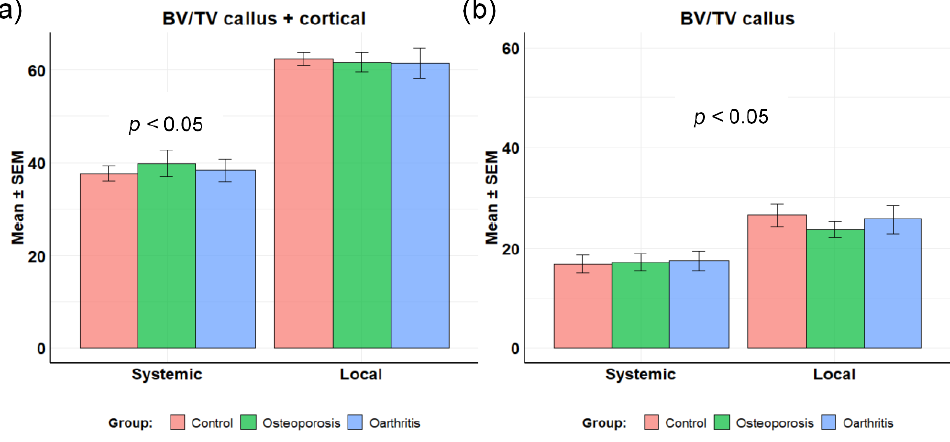
Figure 2. BV/TV of the callus region. ( a ) Callus+cortical BV/TV; ( b ) callus only BV/TV.